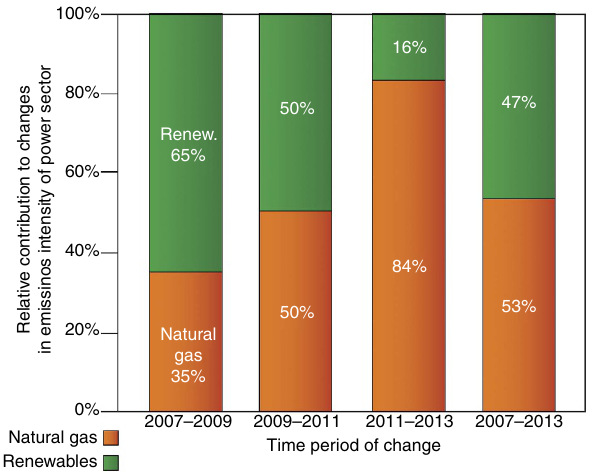
Figure 1 | Relative contributions of natural gas and renewables to the changes in emissions intensity of US power